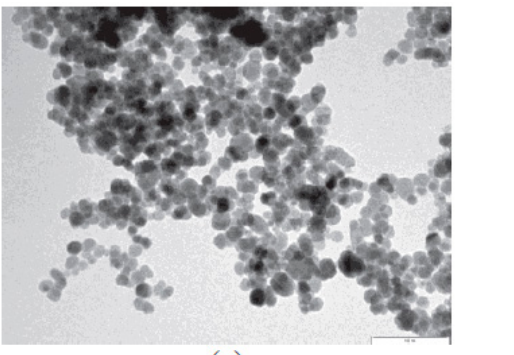
Figure 9. FTIR spectra of ( a ) tryptophan functionalized MNP-2, serine functionalized MNP-5, and ( b ) phenylalanine MNP-4 and tyrosine MNP-6. Reprinted with permission from [50] .